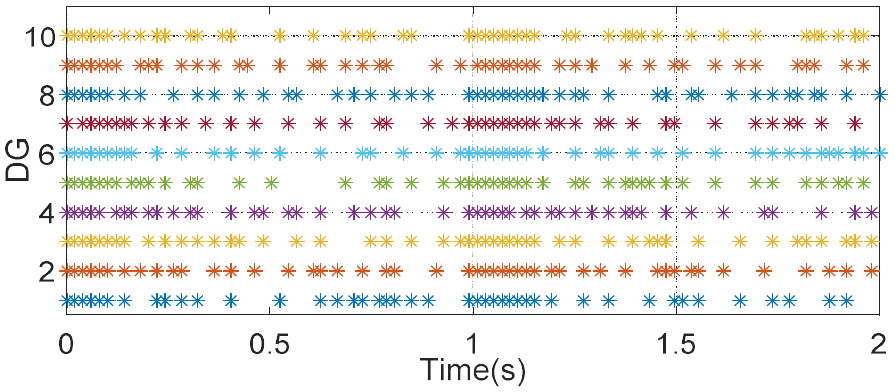
Figure 9. Triggering instant of 10 DGs with ETCP.